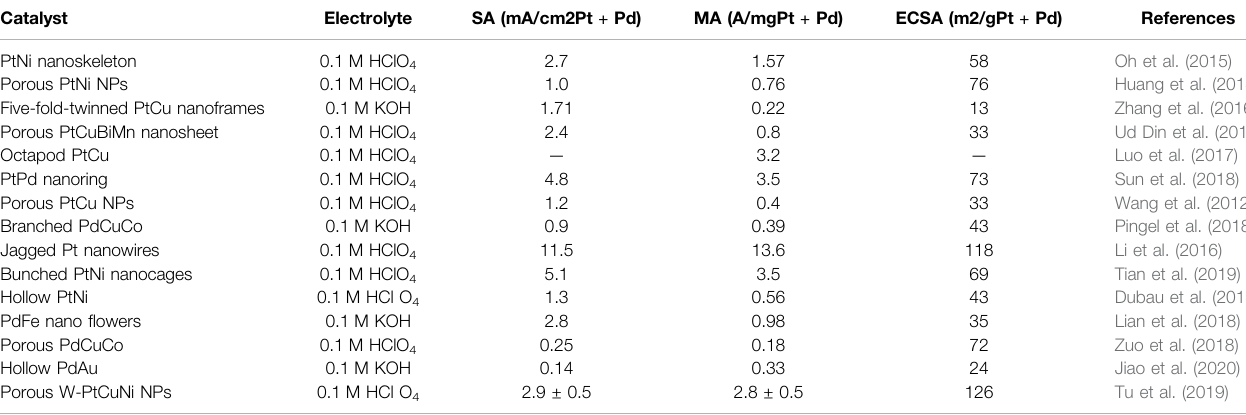
TABLE 4 | Examples of studies that improve ORR activity by surface defects engineering. Catalyst